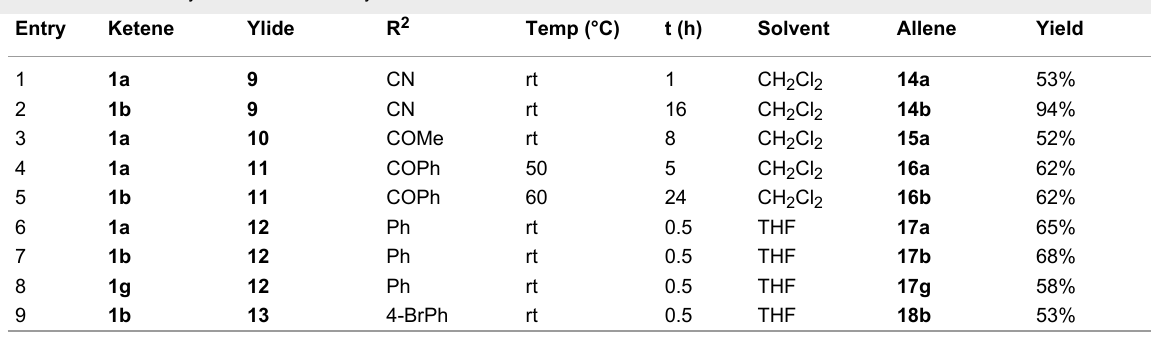
Table 3: Reaction of silylketenes with various ylides Entry